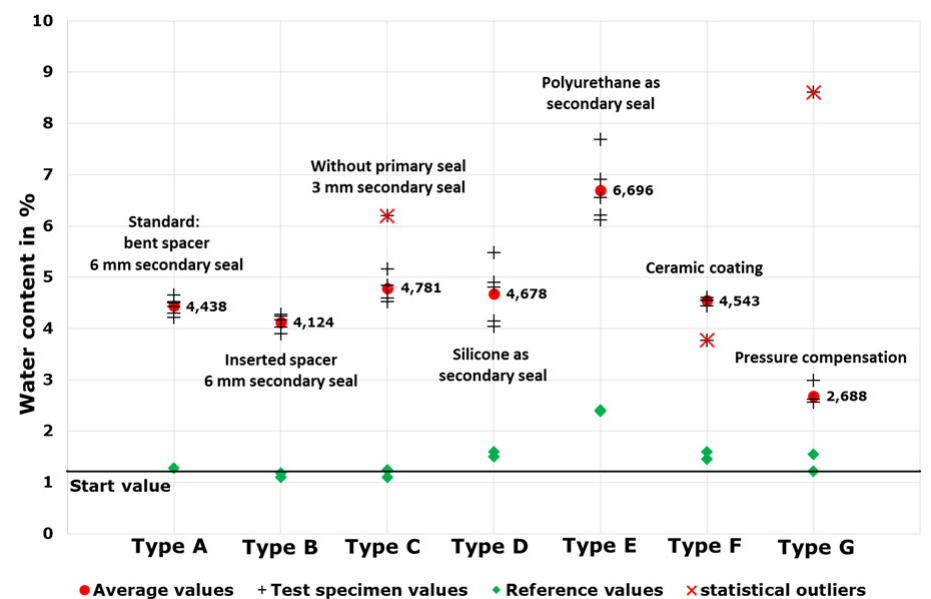
Fig. 8 Moisture content in the desiccant of the insulating glass units after the artificial ageing